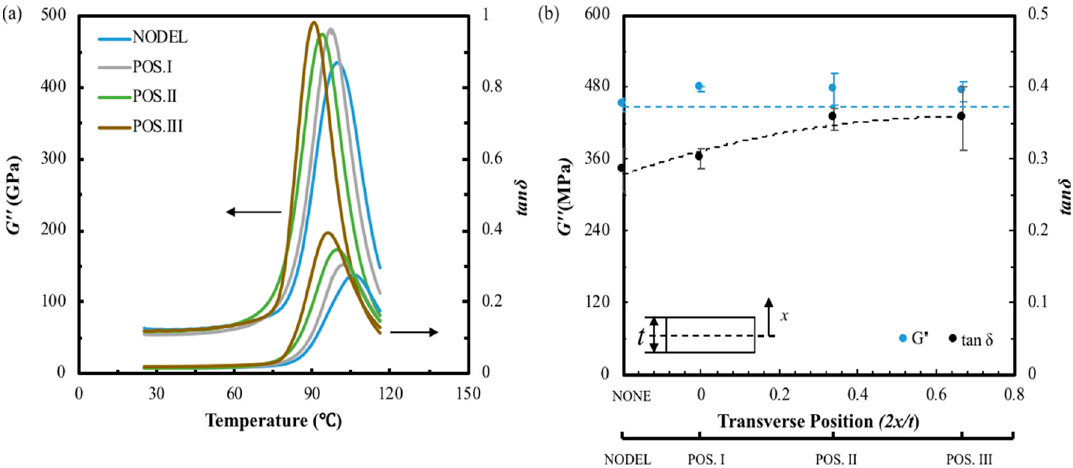
Figure 11. ( a ) Typical loss shear modulus and tan δ against temperature plots, ( b ) the loss shear modulus and loss factor of FFRP composites with different transverse position.